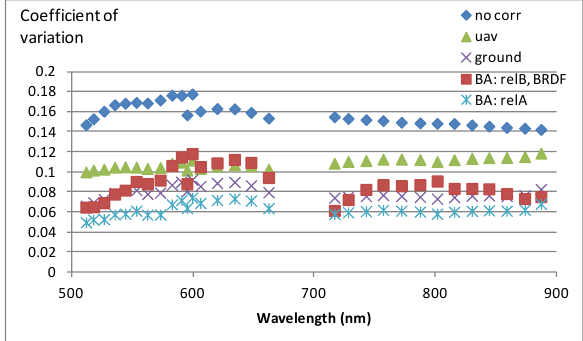
Figure 9. Average coefficients of variation (homogeneity) at radiometric tie points for non corrected data (no corr) and different correction case (Section